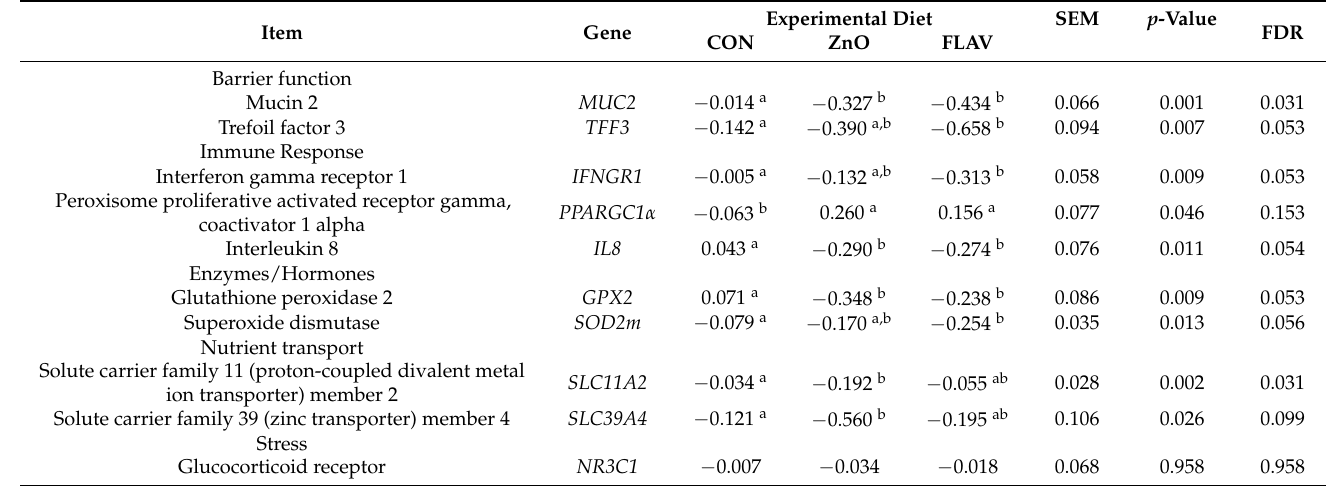
Table 4. Effect of experimental diets on ileum relative gene expression of weaned pigs fed experimen- tal diets.